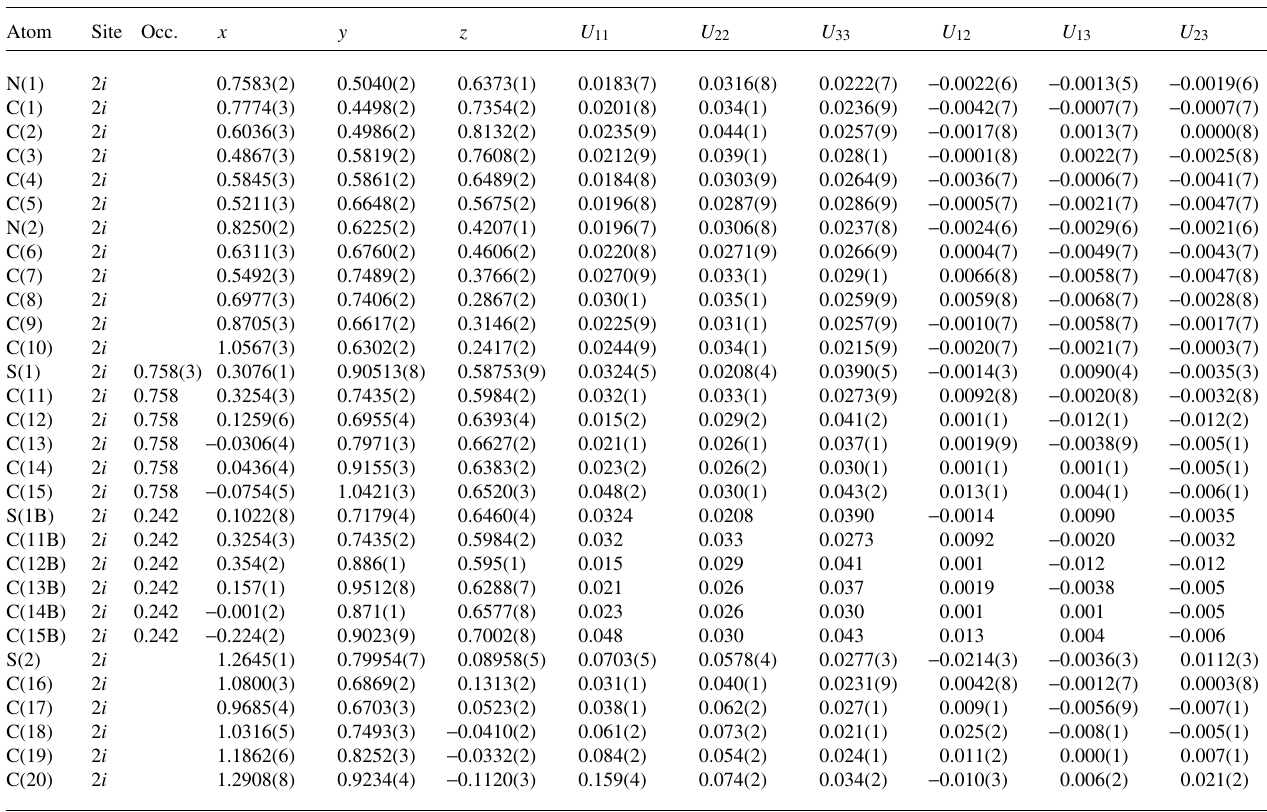
Table 3. Atomic coordinates and displacement parameters (in Å 2 ) .